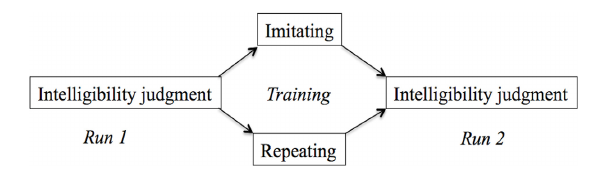
FIGURE 1 | Tasks in the three phases of the experiment. Both groups performed an intelligibility judgment in the first run. Subsequently, the imitation group imitated a series of sentences in an unfamiliar accent, while the repeat group repeated sentences in their own accent. Finally, all participants performed the intelligibility judgment task